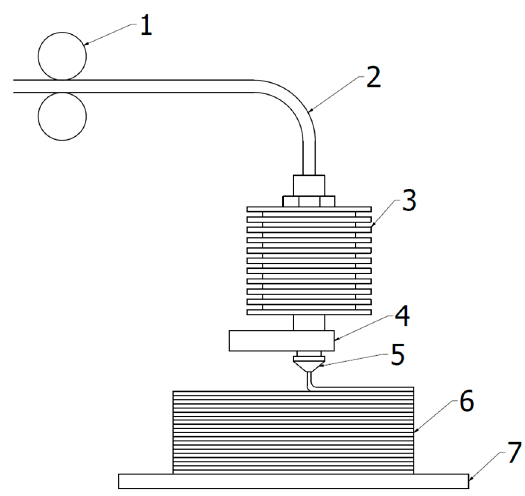
Figure 1. Schematic drawing of 3D printing projection. 1—extruder, 2—filament, 3—heatsink, 4—heatblock, 5—nozzle, 6—printing object, 7—heated